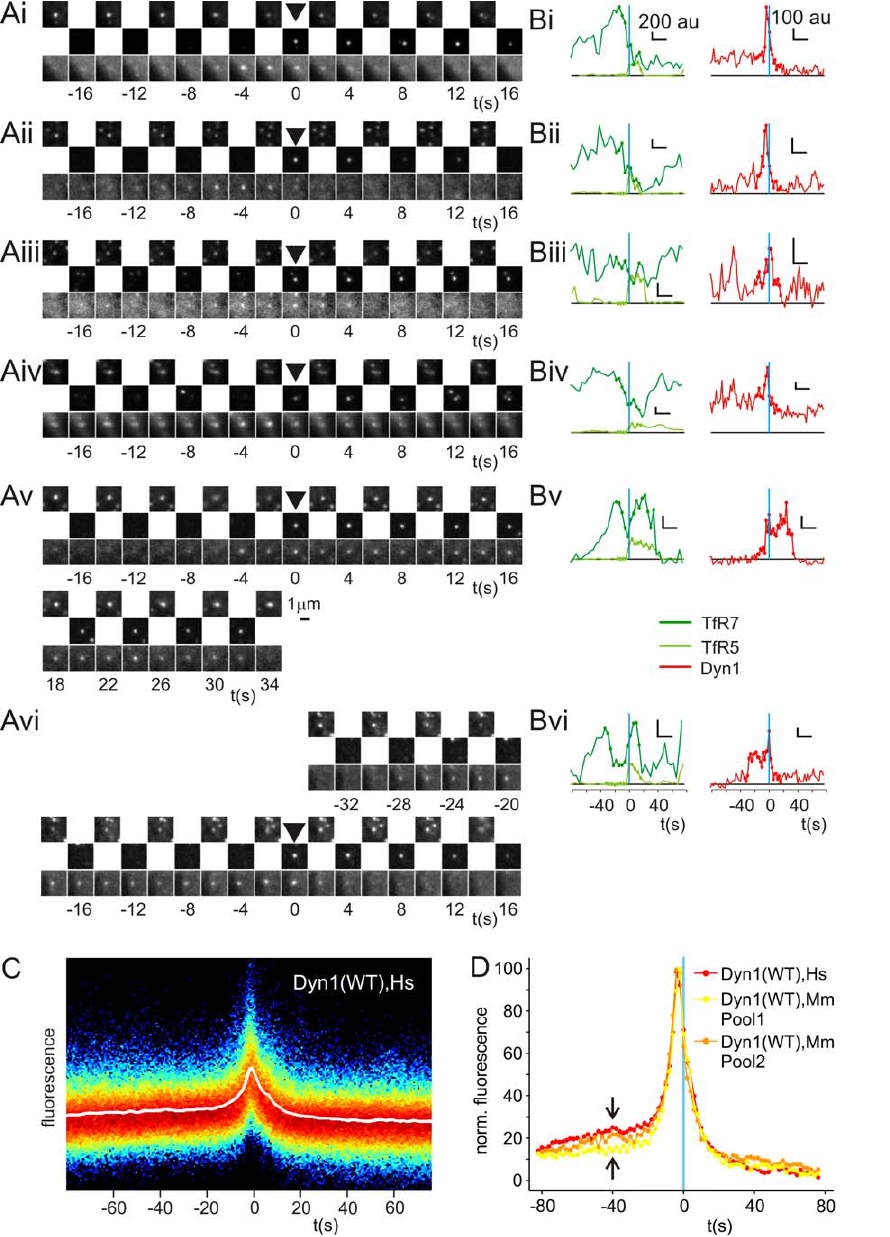
Figure 3. Individual Dyn1-mCherry recruitment events were variable, but the average Dyn1-mCherry recruitment signature was stable. (A and B) Natural variation of Dyn1-mCherry recruitment to sites of scission. (Ai–Avi) Consecutive images of TfR7 (top), TfR5 (middle), and Dyn1-mCherry (bottom) movies centred on scission events detected in the TfR5 movies. The data are from the cell shown in Figure 2A. (Bi–Bvi) Quantification of fluorescence for TfR5 (light green curves), TfR7 (dark green curves), and Dyn1 (red curves) images for the corresponding events shown in (A). Vertical blue lines indicate t =0 s, and black horizontal lines indicate zero fluorescence. Horizontal scale bar corresponds to 20 s, fluorescence values as indicated. Dots correspond to frames shown in (A). (C) The full set of Dyn1-mCherry fluorescence traces were normalised and overlaid as a cloud plot (see Materials and Methods). Red indicates higher data density, blue, lower density, and black, background. The average fluorescence recruitment trace is indicated by a white line. (D) Replicate Dyn1-mCherry recruitment signatures for either human (Hs) or mouse (Mm) Dyn1-mCherry. au, arbitrary units; WT, wild type.